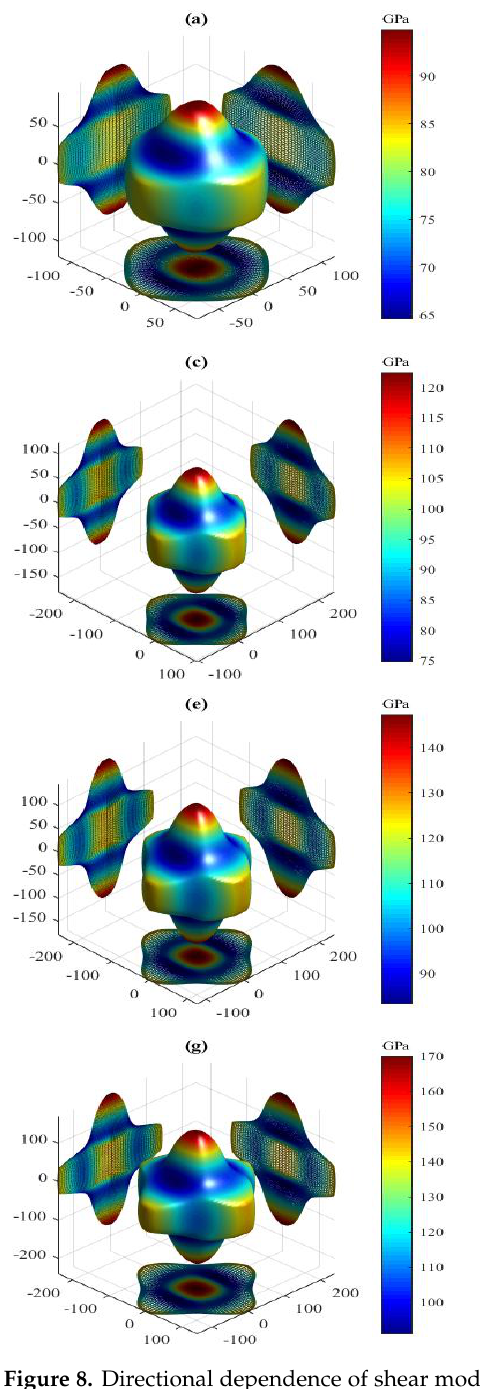
Figure 8. Directional dependence of shear modulus for the LPS h-Al 2 Ti under pressure ( a ) 0